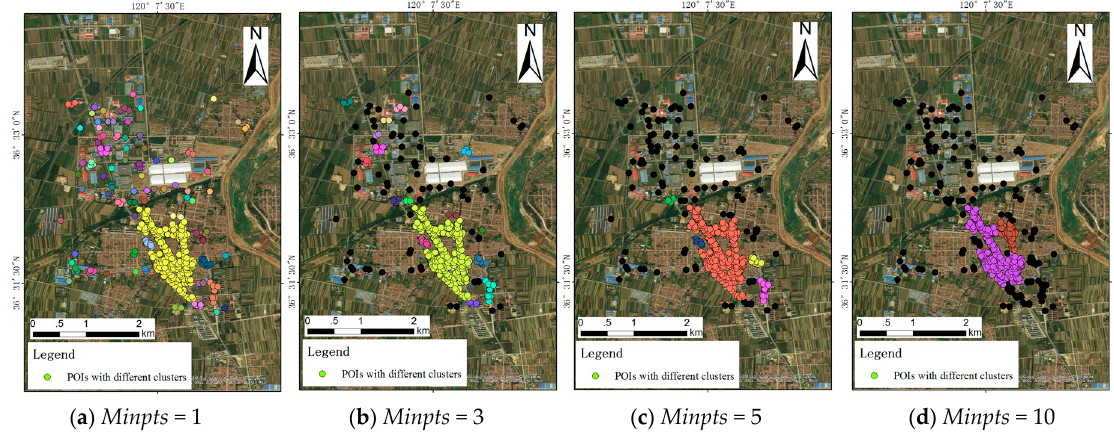
Figure 6. POI clustering results with different parameter Minpts .